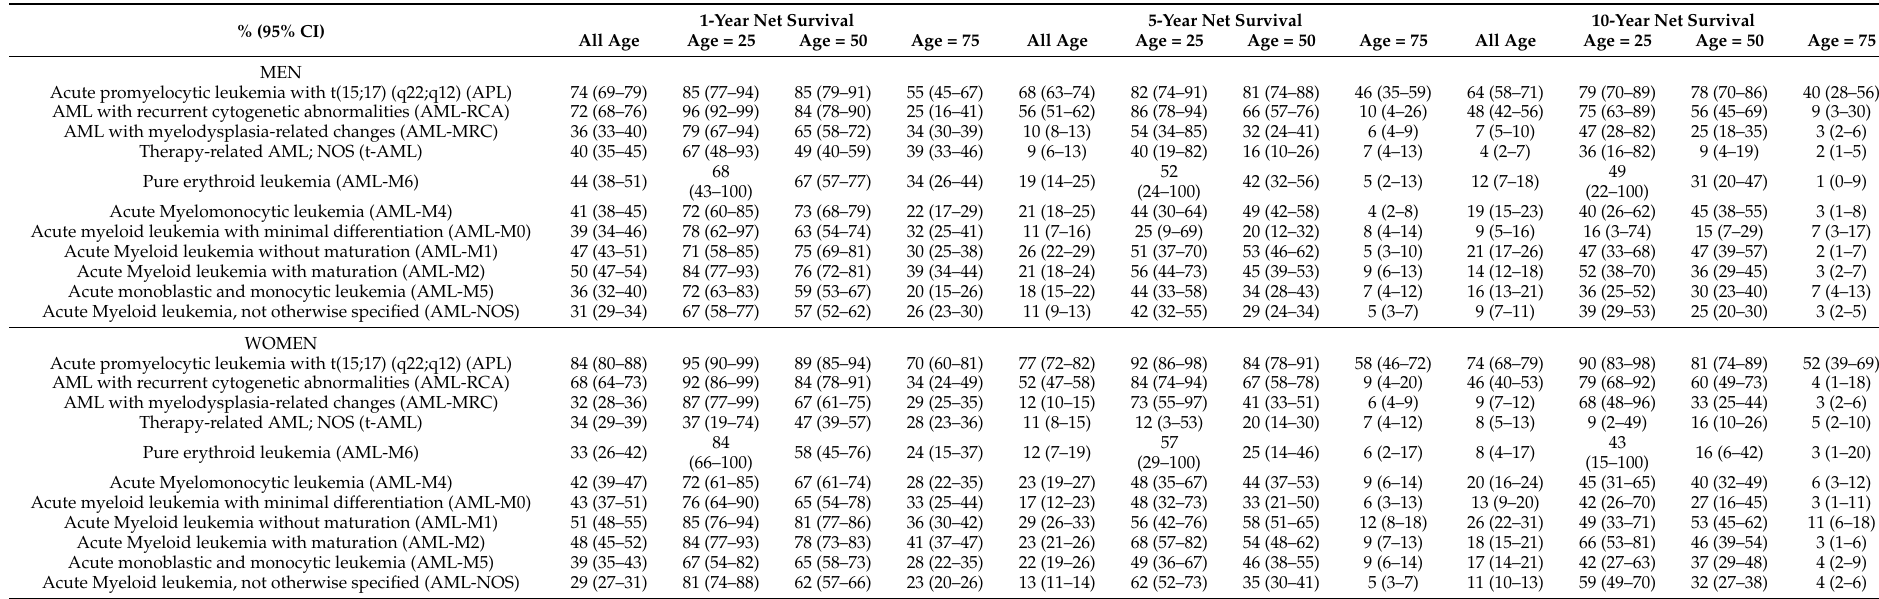
Table 3. Estimated net survival in percent (and 95% confidence interval) at 1, 5 and 10 years after AML diagnosis according to AML subtype and sex for all ages and with age fixed at 25, 50 and 75 years old. Results of the flexible excess mortality model retained in each AML subtype and sex with the covariate of age at diagnosis fixed to values equal to 25, 50 and 75 years